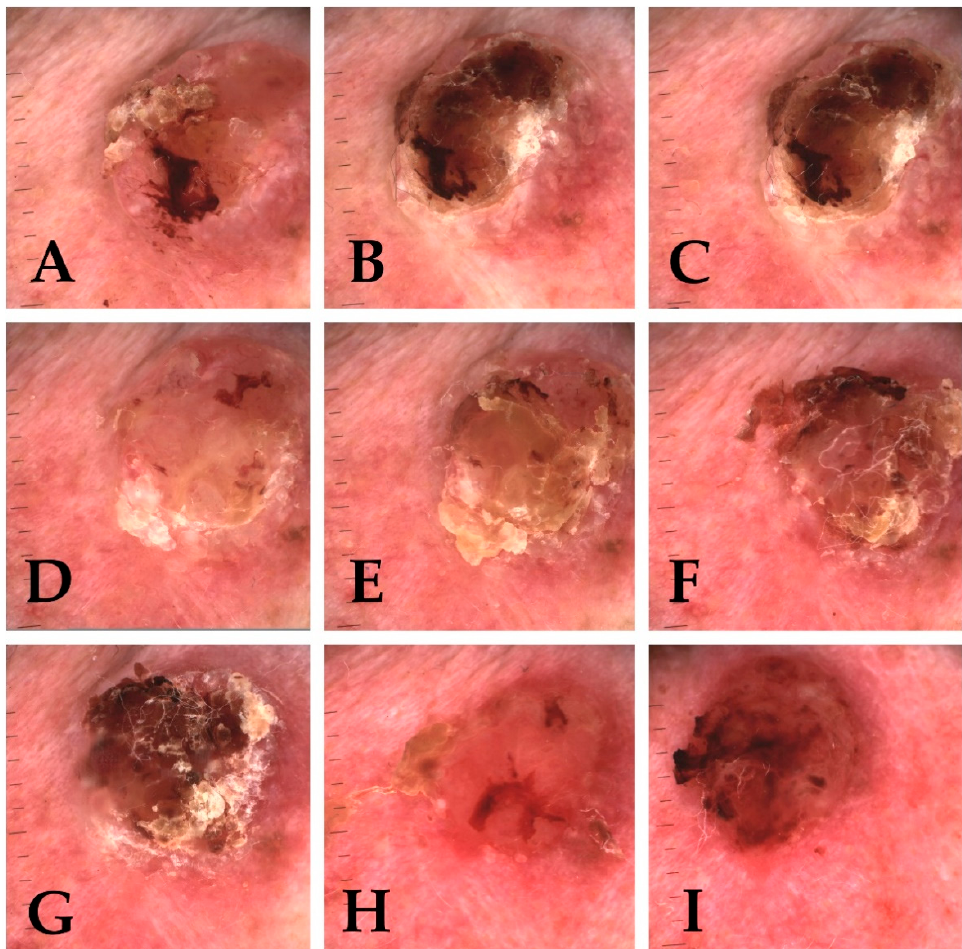
Figure 6. Dermoscopic picture of basal cell carcinoma of the infraorbital region, nodular type, of 67-year-old patient. ( A )—Tumour prior to brachytherapy (t1) exhibit the presence of white clods, white structureless zones and erosion. ( B – I )—White clods and structureless zones gradually vanishing from 5th fraction (t5), with developing predominance of ulceration.